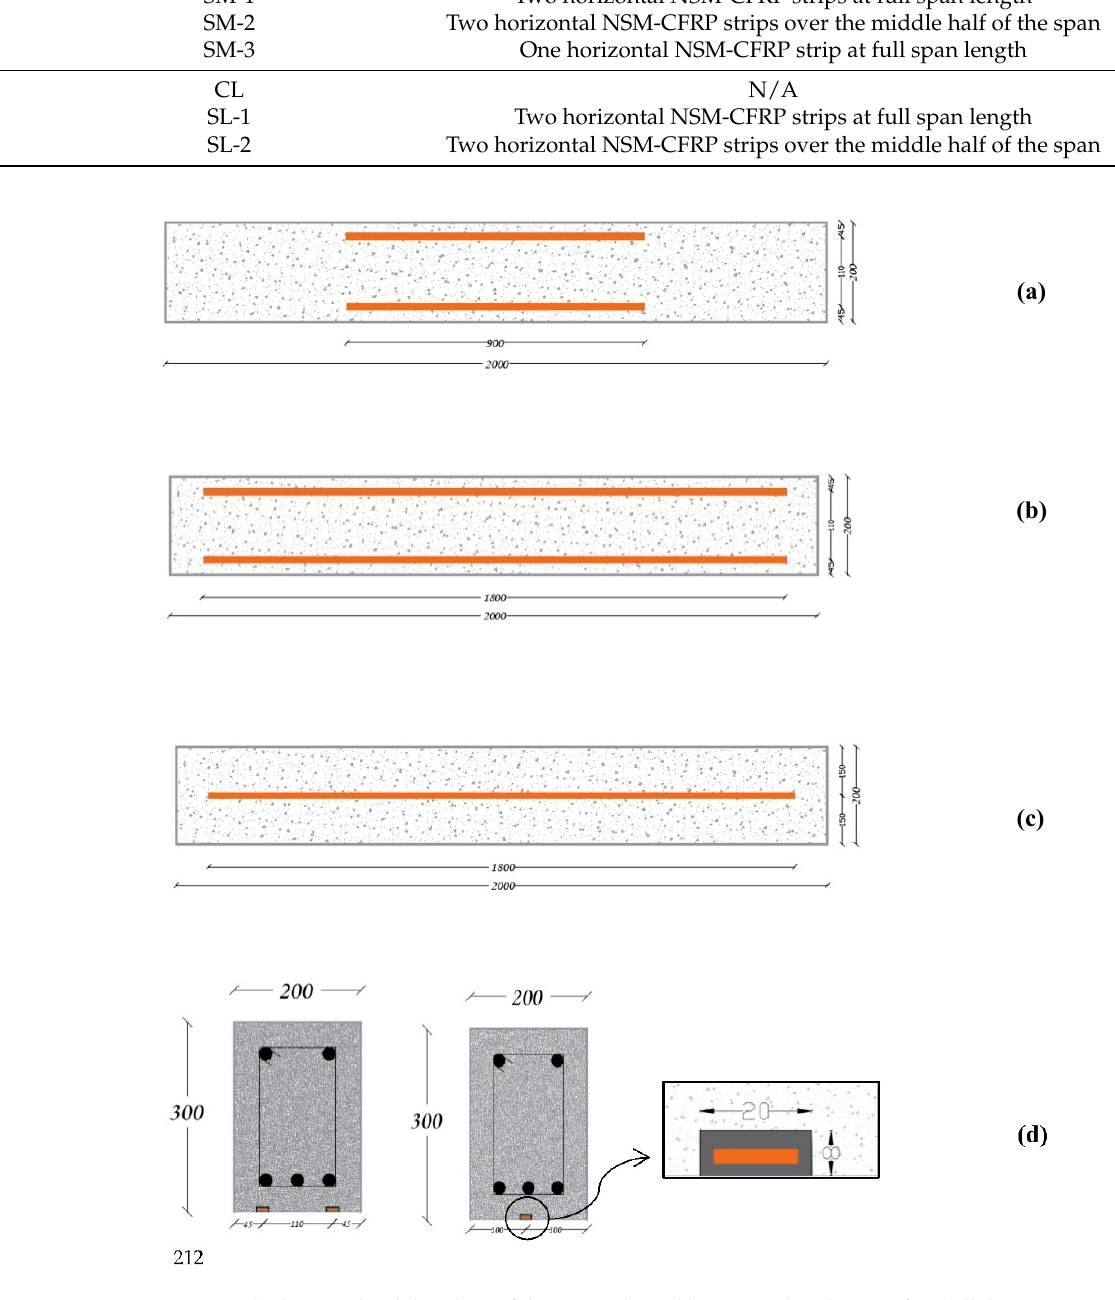
Figure 1. The longitudinal detailing of the strengthened beams at their bottom face (all dimensions are in mm ) . ( a ) Two NSM-CFRP-strips (SH-1, SM-1, SL-1) at full span length. ( b ) Two NSM-CFRP-strips (SH-2, SM-2, SL-2) over the middle half of the span. ( c ) One NSM-CFRP-strip (SH-3, SM-3) at full span length. ( d ) Cross-sectional details of the strengthened specimens.